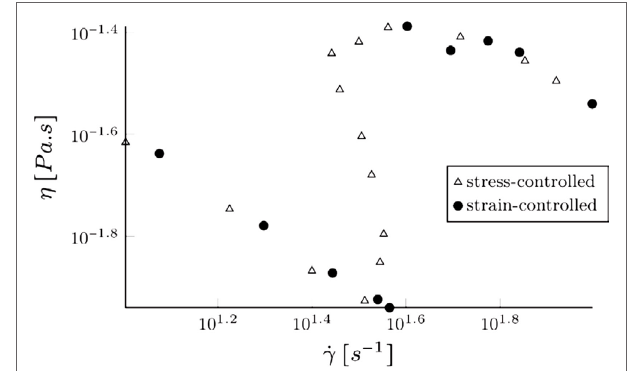
FigURe 5 | variation of apparent viscosity with shear rate in the experiment by Boltenhagen et al. (1997) .